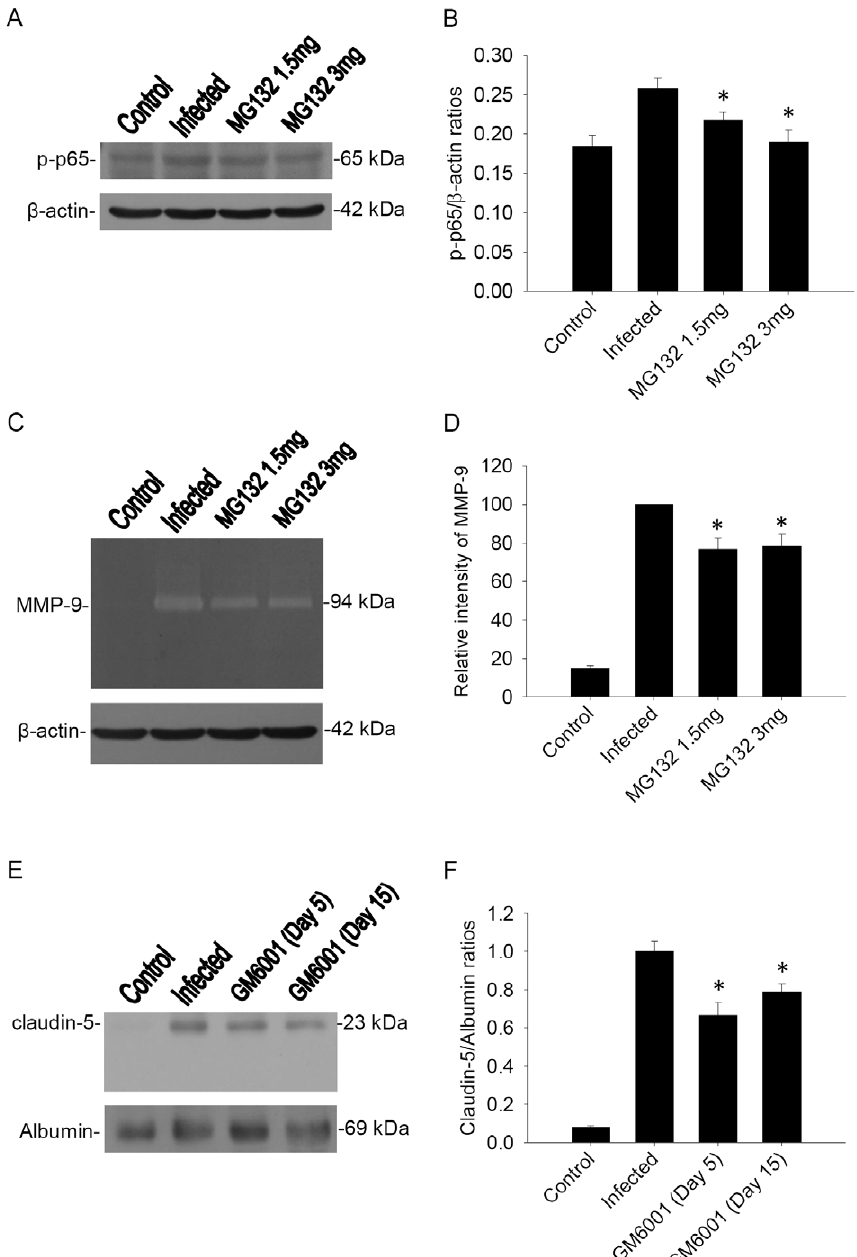
Figure 3. Influence of treatment with MG132 and GM6001 after infection. The test groups were: uninfected mice (control), n=5; A. cantonensis -infected untreated mice (infected), n=5; mice treated with 1.5 mg of MG132, n=5; mice treated with 3 mg of MG132, n=5; mice treated with GM6001 on day 5 PI, n=5; and mice treated with GM6001 on day 15 PI, n=5. (A) The p-NF- k B p65 bands were analyzed by western blotting using specific antibody from the brains. (B) Ratios of p-NF- k B p65/ b -actin showed significant decrease (* P , 0.05) in MG132 in treated mice versus infected mice. (C) The MMP-9 activities were analyzed by gelatin zymography from the brains. (D) The intensities of MMP-9 were decreased significantly (* P , 0.05) in MG132-treated mice versus infected mice. (E) The claudin-5 bands were analyzed by western blotting using specific antibody from the CSF. (F) Ratios of claudin-5 were decreased significantly (* P , 0.05) in GM6001-treated mice versus infected mice. Bars represent mean 6 S.D. from three independent experiments performed in